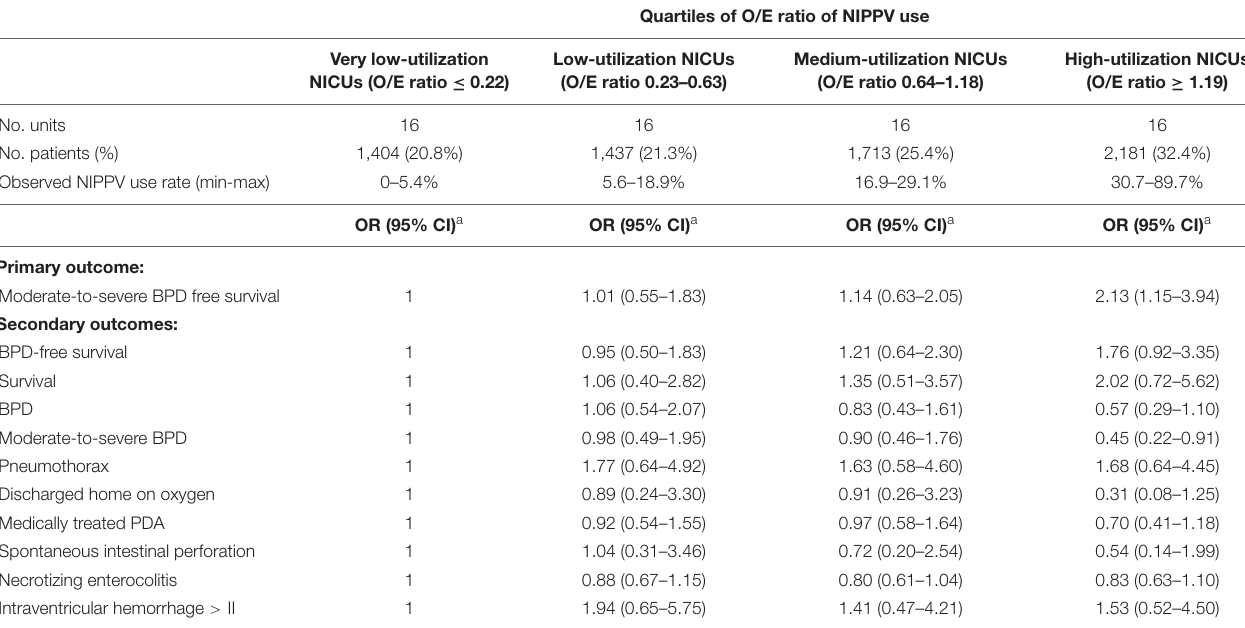
TABLE 3 | Primary and secondary outcomes according to the hospital rate of non-invasive positive pressure ventilation (NIPPV). Quartiles of O/E ratio of NIPPV use Very low-utilization Low-utilization NICUs NICUs (O/E ratio ≤ 0.22) (O/E ratio